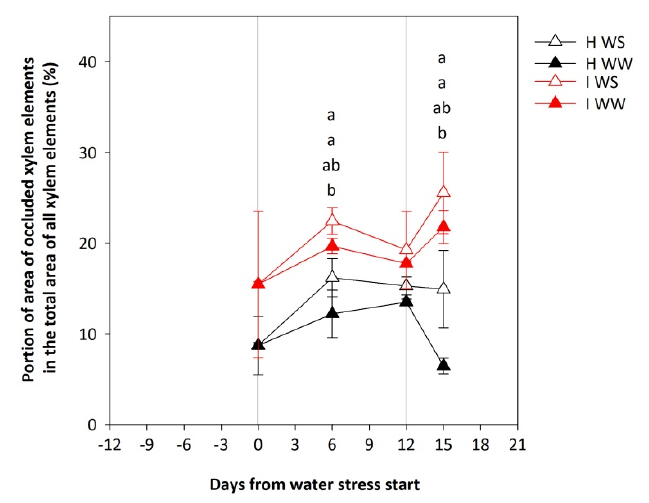
Figure 4. Portion of area of occluded xylem elements in the total area of all xylem elements of potted own-rooted grapevines of cv. Schioppettino before the water stress, during the water stress, and after the recovery. Plants are separated regarding their plant health and water status: well--watered healthy (H WW), well-watered GFLV-infected (I WW), water-stressed healthy (H WS) and water-stressed GFLV-infected (I WS) plants. Error bars represent standard errors. For each time point separately, data were processed through ANOVA (significance reported in Supplementary Table S1), and means were separated with a Student Newman Keuls test ( p < 0.05; different letters represent significant differences between means). Grey lines represent the beginning and the end of water stress period.